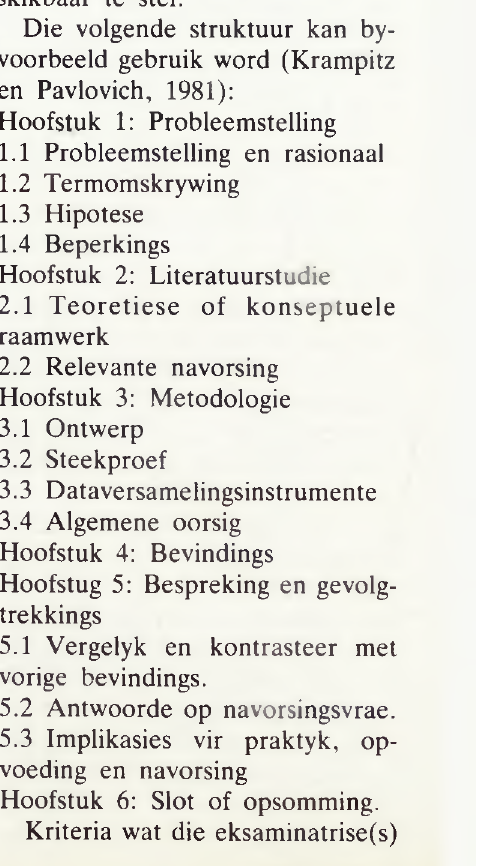
Hoofstug 5: Bespreking en gevolg- trekkings 5.1 Vergelyk en kontrasteer met vorige bevindings. 5.2 A ntw oorde op navorsingsvrae. 5.3 Implikasies vir praktyk, op­ voeding en navorsing H oofstuk 6: Slot of